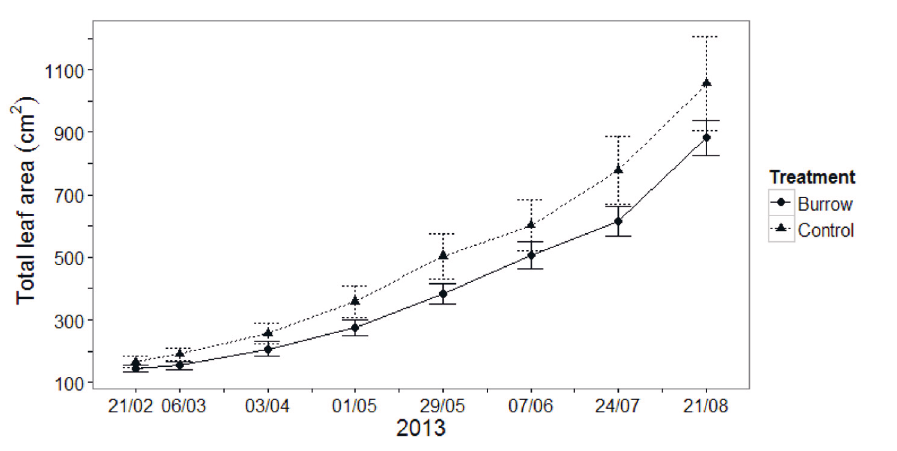
Figure 4. Mean total leaf area (cm 2 , n = 9 for each treatment) from the first sampling (21 February 2013) to the last sampling (21 August 2013). Treatments are indicated by different point and line types. Error bars represent the standard error (SE).